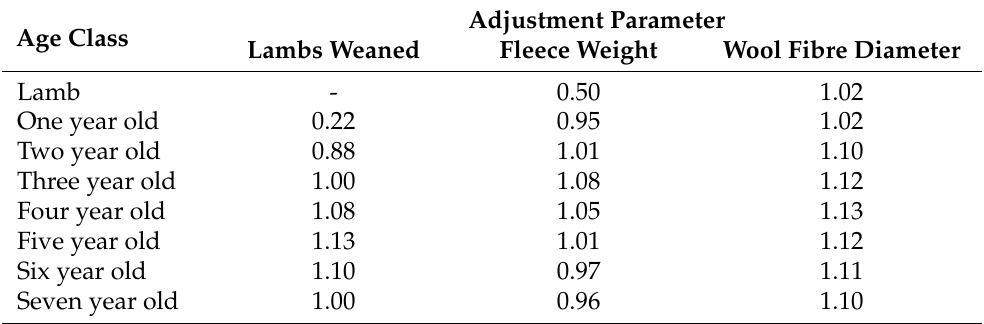
Table 1. Adjustment parameters for lamb and wool production estimations of sheep of various age classes in the flock. Adapted from previous studies using the same model